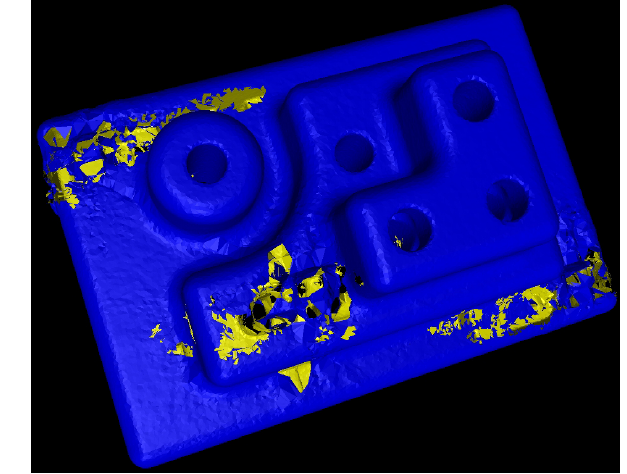
Figure 4. Visualization of a corrected surface. Yellow regions in- dicate faulty triangulation correspondences due to point cloud pro- cessing.